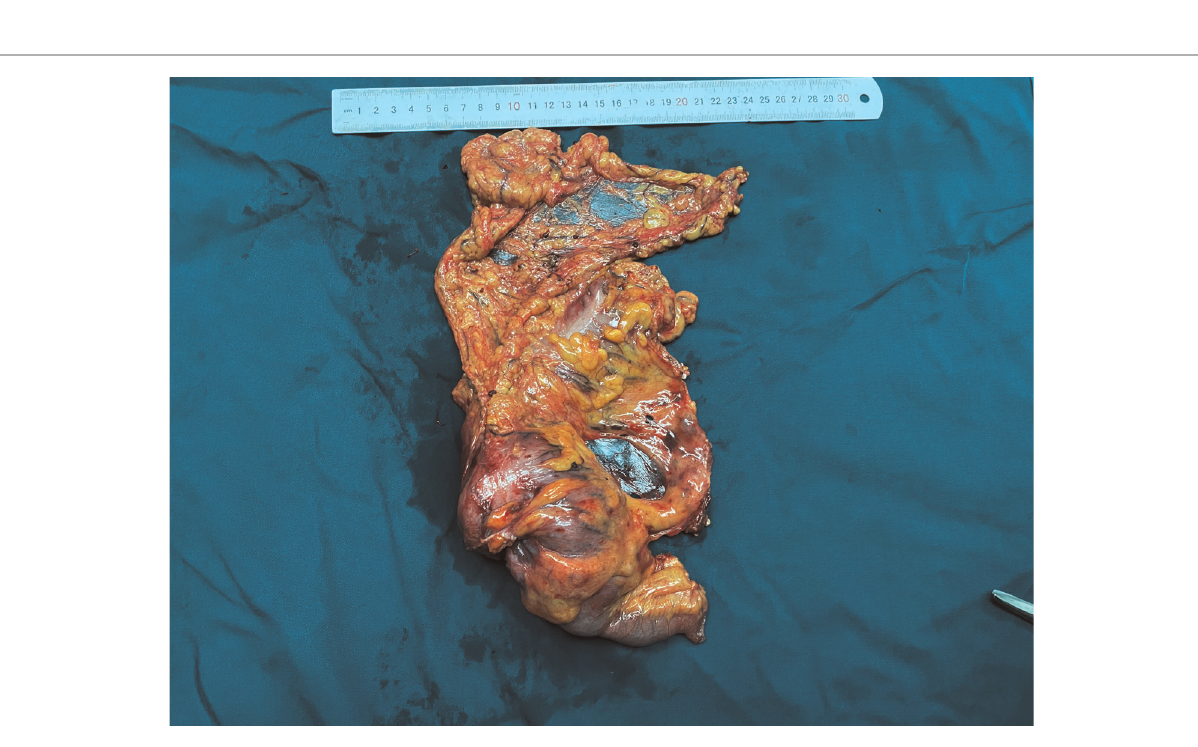
FIGURE 3 The surgical gross